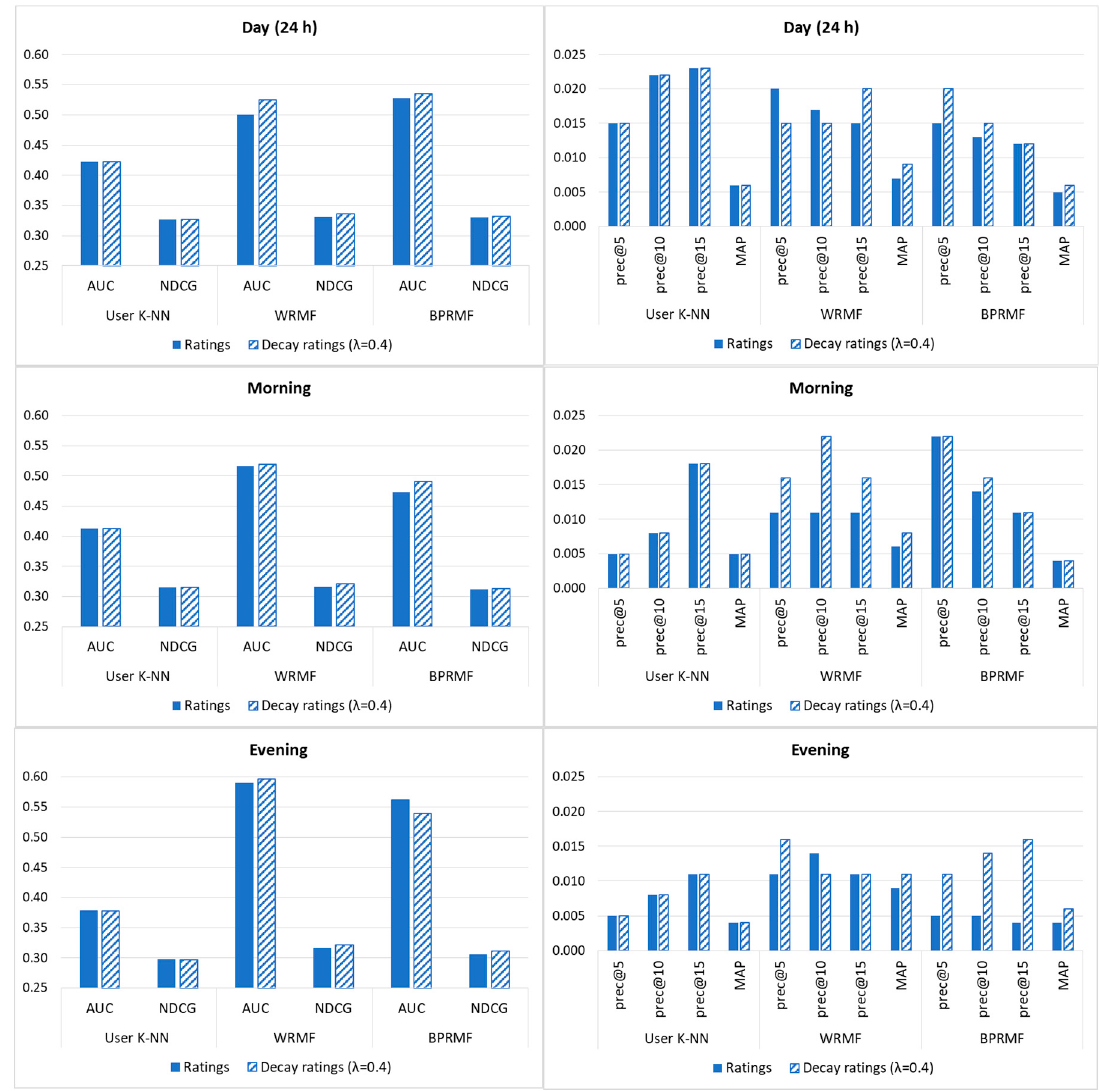
Figure 2. Values of the top-N metrics given by user K-nearest neighbor (K-NN), weighted matrix factorization (WRMF) and Bayesian personalized ranking matrix factorization (BPRMF) using rating and decay ratings.